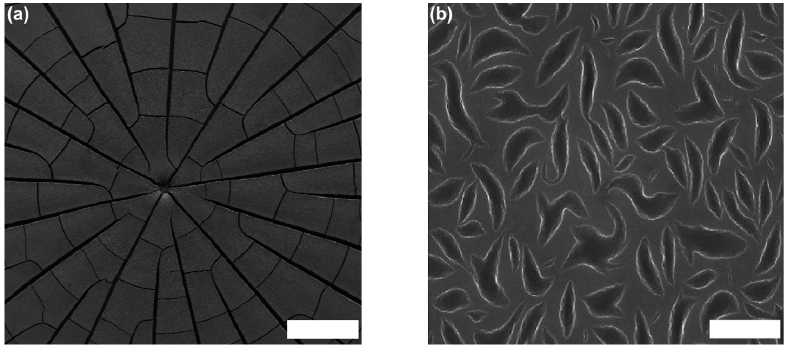
Figure 4. ( a ) SEM image of dried drops for a ratio of silica NPs (diameter: 10 nm)/DNA (20,000 bp) ratio 1:0.5. The scale bar is 200 µm. ( b ) HR-SEM images of dried drops for an NP/dsDNA ratio of 1:0.5. The scale bar is 2 µm. Adapted with permission from [32] (p. 3663). Copyright 2014 Springer Nature.